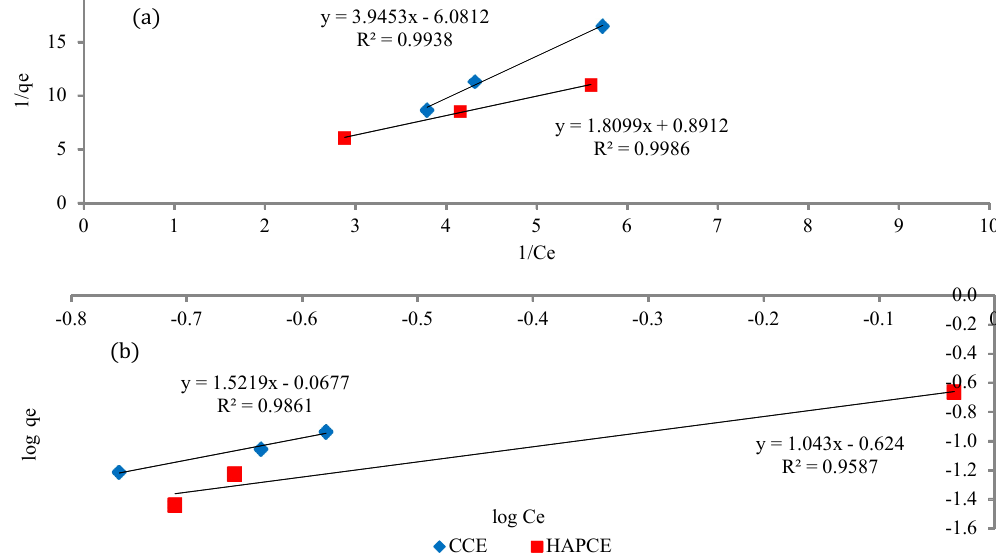
y = 3.9453x - 6.0812 R² = 0.9938